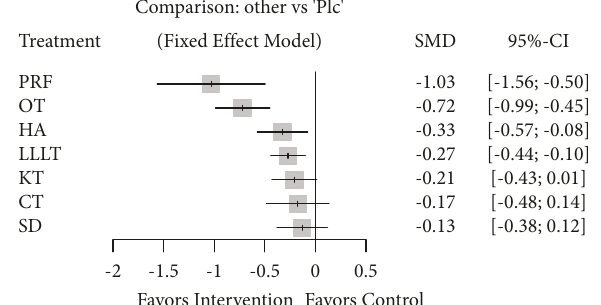
Figure 10: Forest plot comparing different complementary in- terventions for reducing late pain after third molar surgery. PRF: platelet-rich fibrin; SD: surgical drainage; CT: cryotherapy; HA: hyaluronic acid; KT: Kinesio taping; LLLT: low-level laser therapy; OT: ozone therapy; Plc: placebo.